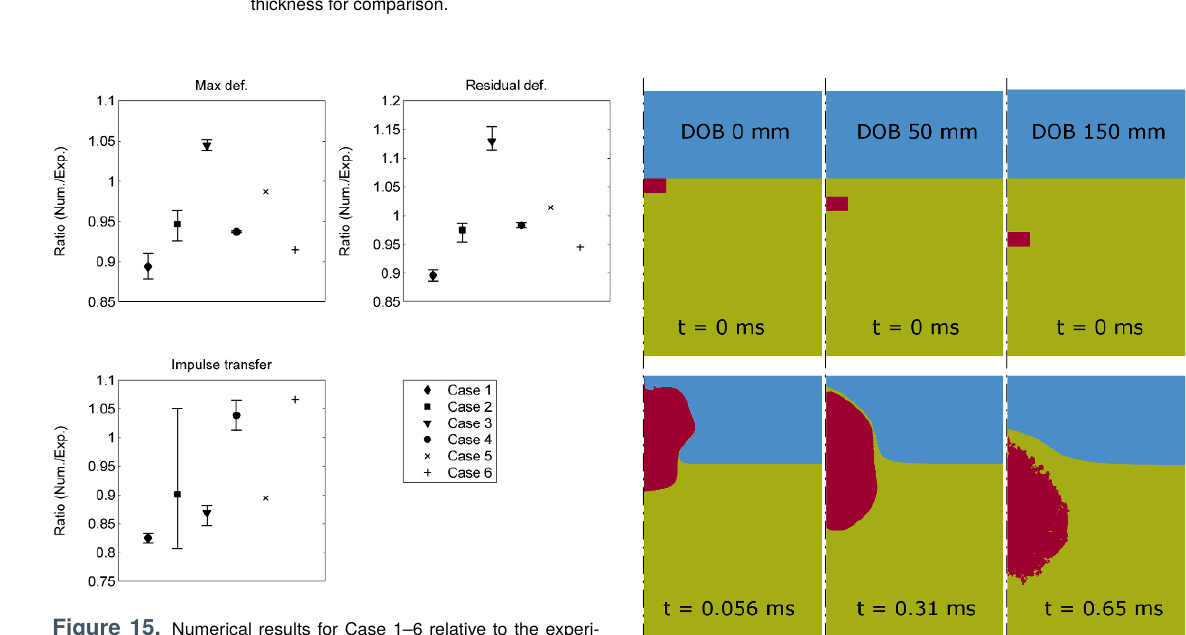
Figure 14. Experimental (left) and numerical (right) visualisation of the deformed target plate mounted on the test module. The numerical view has been reflected from quarter- to full symmetry and shell elements are visualized with actual thickness for comparison.